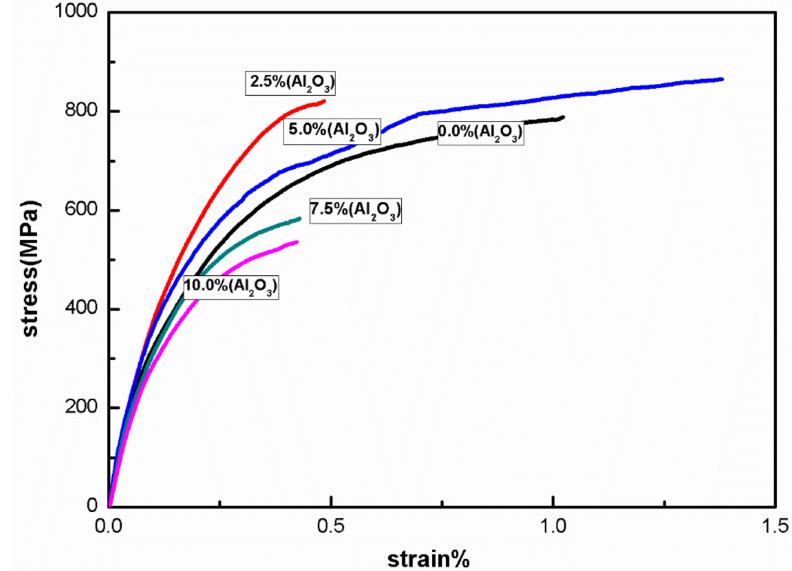
Figure 14. Stress–strain curves of CoCr alloy doped with di ff erent percentages of Al 2 O 3